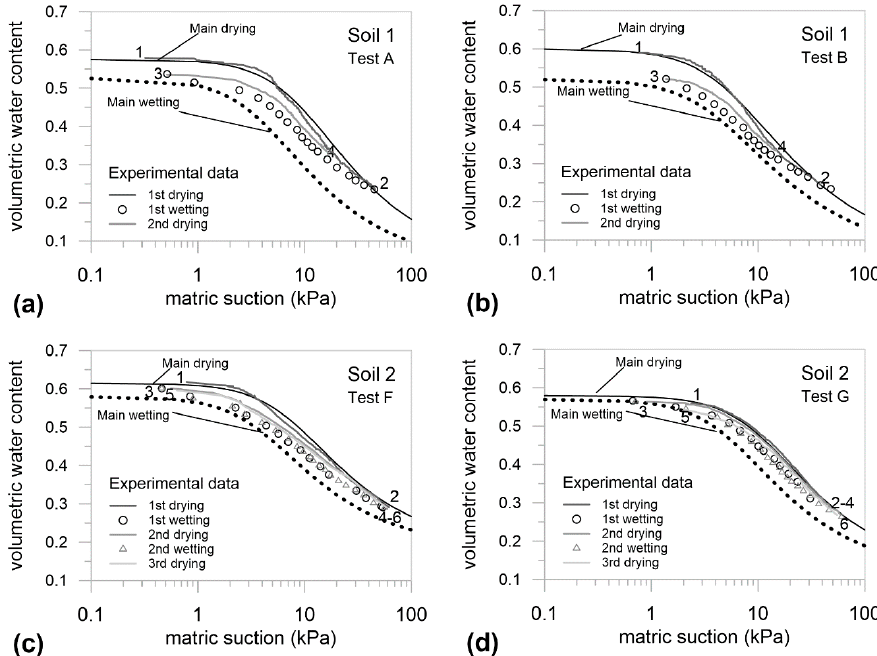
Figure 5. Results on soils 1 and 2 through laboratory tests (small scale). The main loop obtained from inverse analysis (main drying and main wetting) overlaps with the experimental data (main drying and wetting–drying cycles) of tests ( a ) A, ( b ) B, ( c ) F, and ( d ) G.